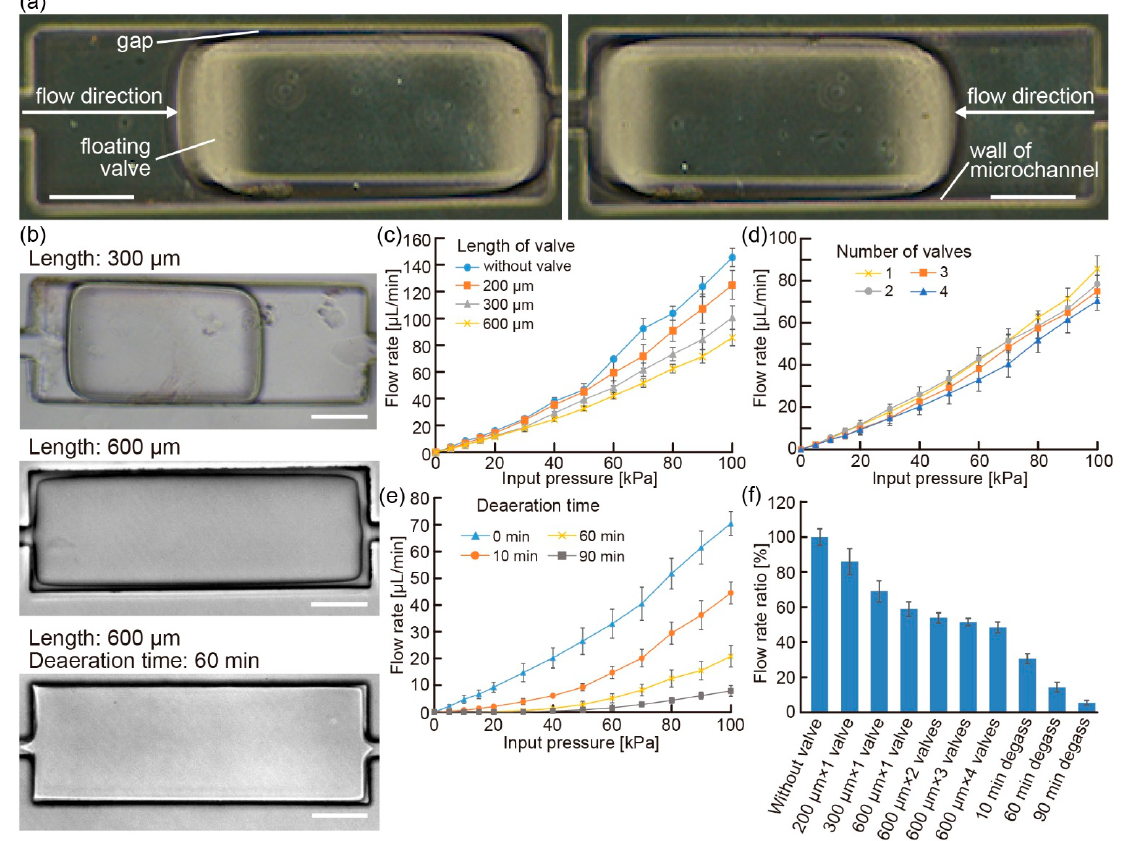
Figure 3. ( a ) Images of the floating valve in motion according to the flow direction (scale bars: 100 μm); ( b ) images of the floating valves with different shapes controlled by the exposure pattern and degassing time (scale bars: 100 μm); ( c – e ) changes in the regulation properties of the floating valves with varying input pressure of liquids when the (c) length, (d) number (length: 600 μm), and (e) degassing time of the floating valves were changed; and ( f ) summary of the regulation properties of the floating valves fabricated under different conditions at 100 kPa input pressure.